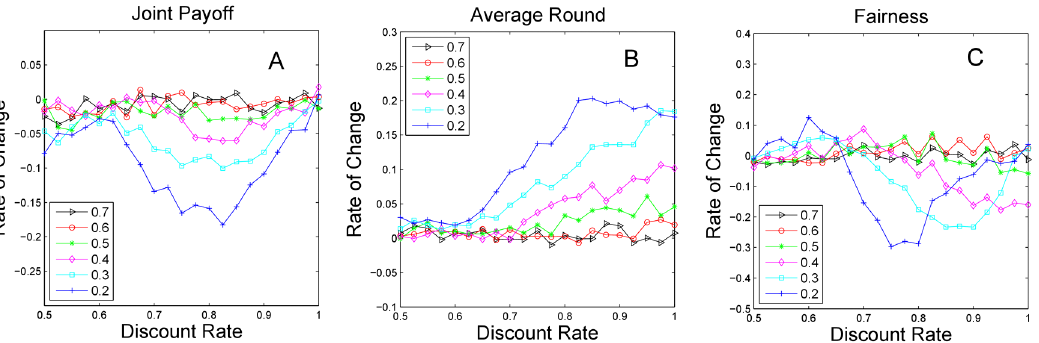
Figure 3. Impact of historical weight on payoff, time and fairness. Figures 3A, 3B and 3C illustrate the change in joint payoff, negotiation time, and fairness with different weights, compared with a weight of 0.8 as the baseline. Because the performance of agents with weights of 0.8 and 0.9 are very similar, the results for a weight of 0.9 are not displayed in Figure 3. To concisely demonstrate the result, we select the representative data with weights between 0.2 to 0.7 based on the benchmark of 0.8.